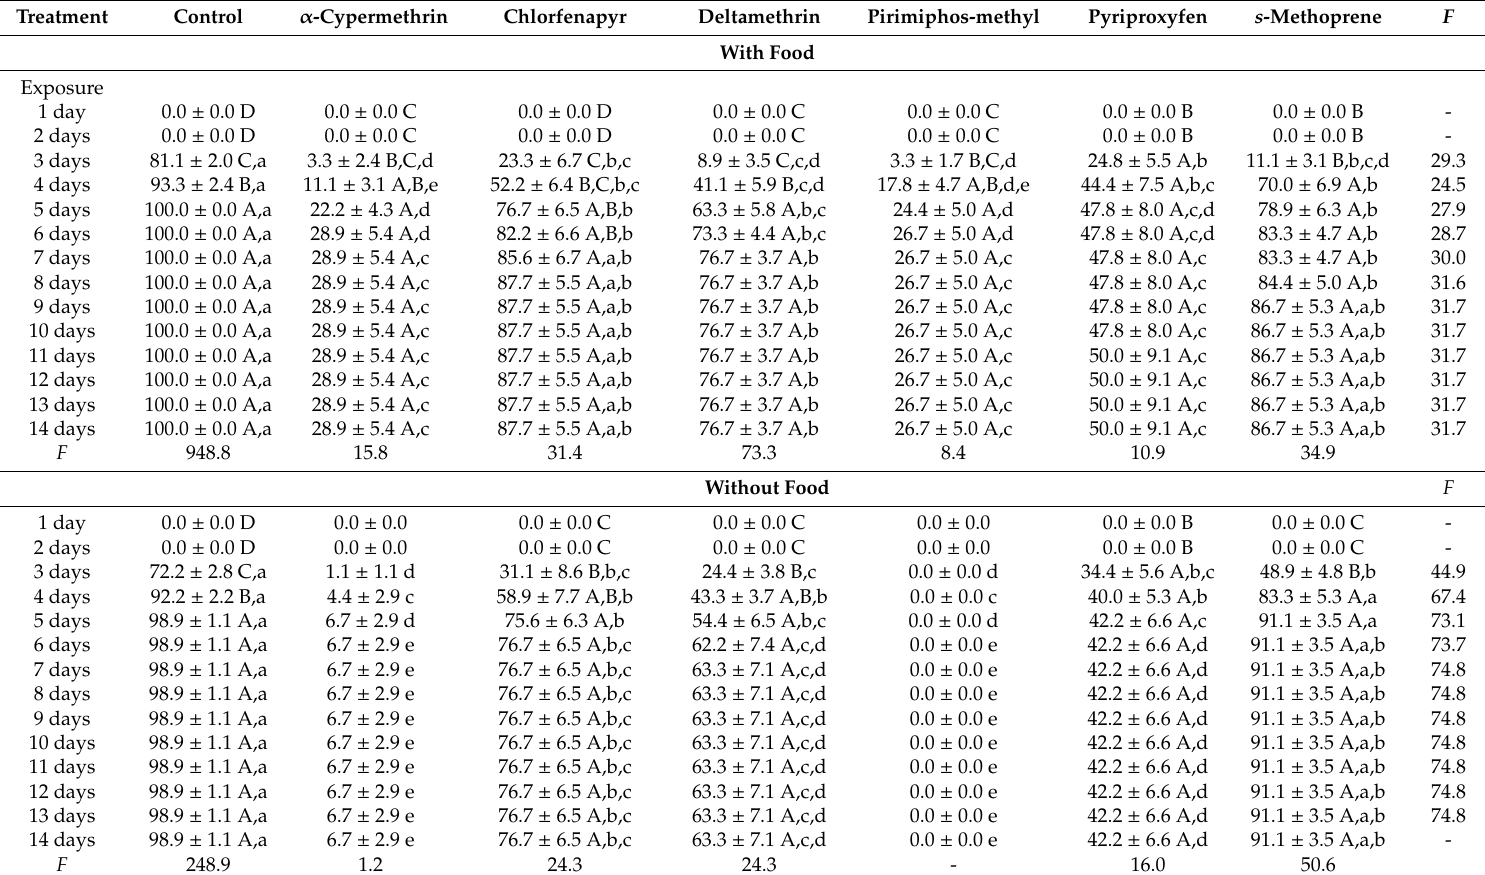
Table 2. Mean percent (% ± SE) of egg hatching of Trogoderma granarium on concrete treated with α -cypermethrin, chlorfenapyr, deltamethrin, pirimiphos-methyl, pyriproxyfen, and s -methoprene, and on untreated concrete (control) after 1, 2, 3, 4, 5, 6, 7, 8, 9, 10, 11, 12, 13, and 14 days with or without food. Within each column, means followed by the same uppercase letter are not significantly di ff erent (in all cases DF = 13, 125, p < 0.01, Tukey–Kramer honest significant di ff erence (HSD) test at 0.05). Within each row, means followed by the same lowercase letter are not significantly di ff erent (in all cases DF = 6, 62, p < 0.01, Tukey–Kramer HSD test at 0.05). Where no letters exist, no significant di ff erences were recorded. Where dashes exist, no statistical analysis was